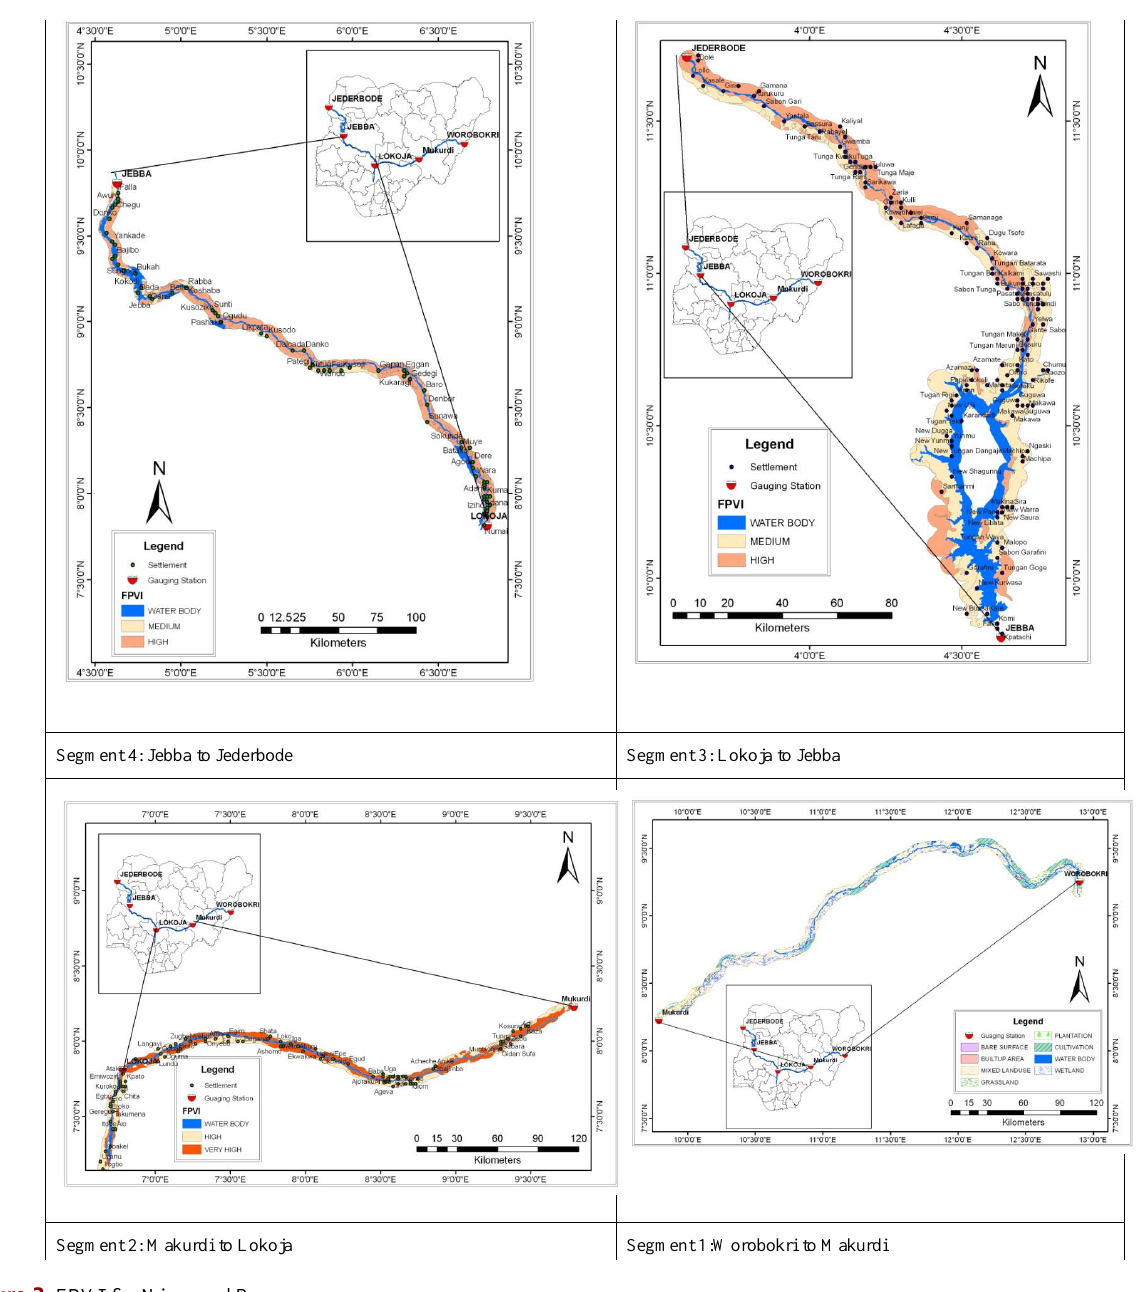
Figure 3: FPVI for Niger and Benue Figure 3. FPVI for Niger and Benue. Table 2. Peak flow